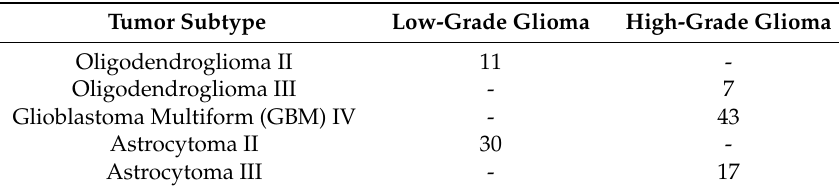
Table 1. Low-grade glioma and high-grade glioma composition.